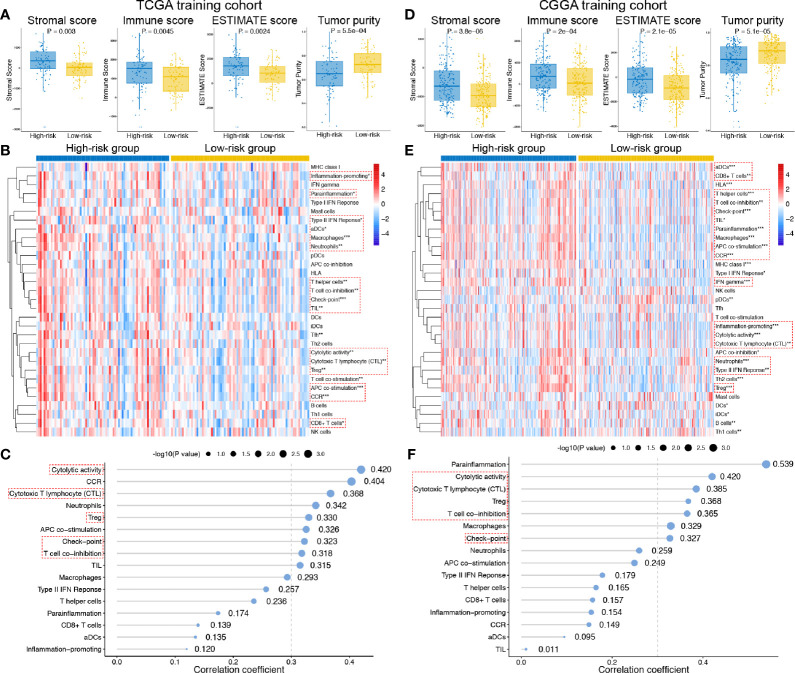
Associations between the exo-lncRNA signature and tumor immune microenvironment in the TCGA training set and CGGA validation set. (A, C) Comparisons of the infiltration level of stromal and immune cells, the ESTIMATE score and tumor purity between high- and low-risk group by boxplots. (B, E) Comparisons of the ssGSEA scores of 31 immune signatures between high- and low-risk group by heatmap. Red dotted boxes indicated 16 intersected immune signatures in both training and validation cohort. *means P < 0.05, **means P < 0.01, and ***means P < 0.001. (C, F) Correlation analysis between the exo-lncRNA signature and 16 immune signatures. Red dotted boxes indicated five intersected immune signatures in both training and validation cohort.